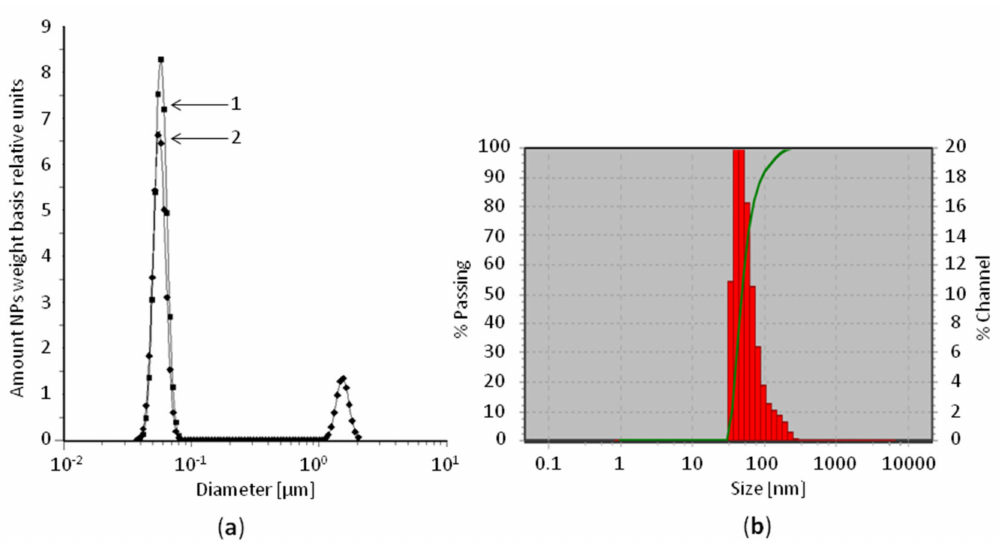
Figure 3. Results of SiO 2 particle size measurement by ( a ) spectroacoustic study (1—after sonication; 2—before sonication) and ( b ) dynamic light scattering (sonicated). In ( b ) x-axis: particle size, nm. Y-axis: left—the fraction of particles with a diameter at least this, % (line); right—the fraction of particles in the size range, %